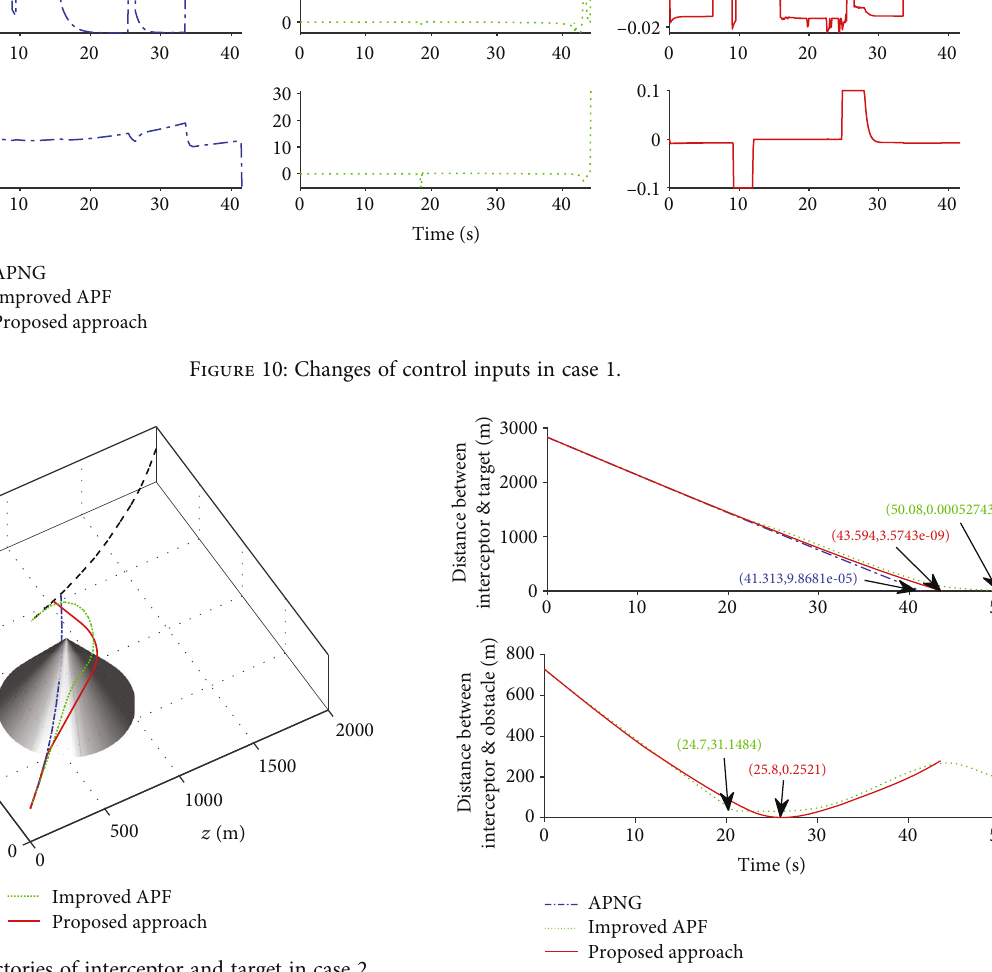
Figure 12: Changes of two distances in case